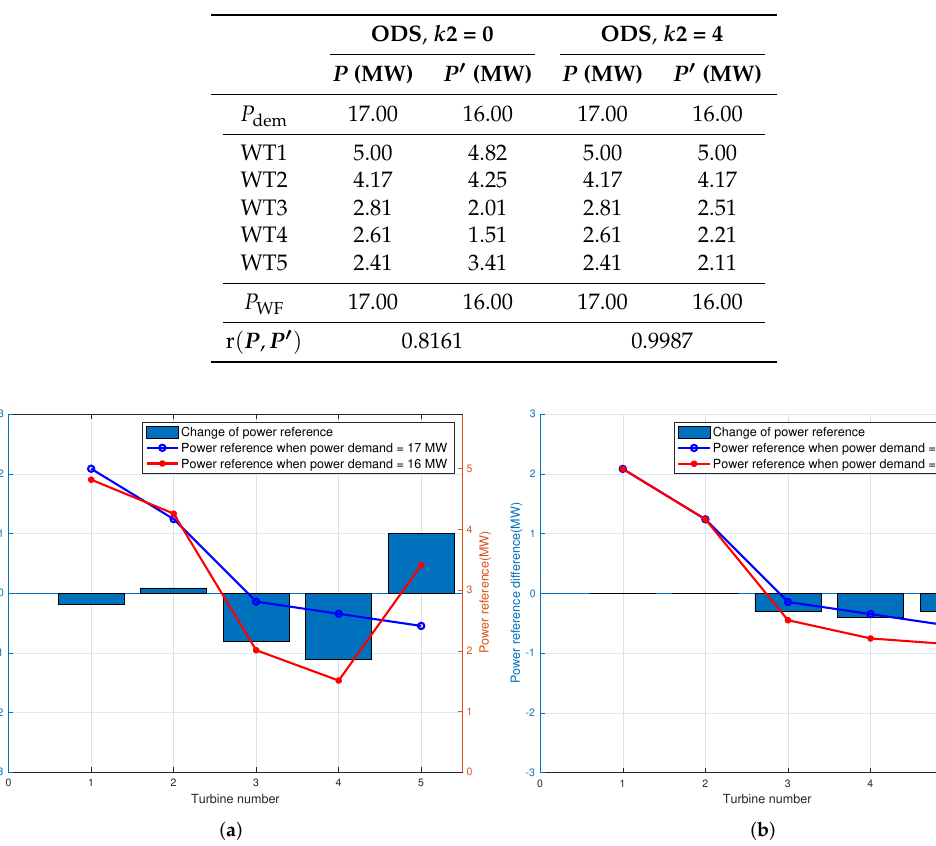
Table 3. Comparison of power fluctuation in Case 2.